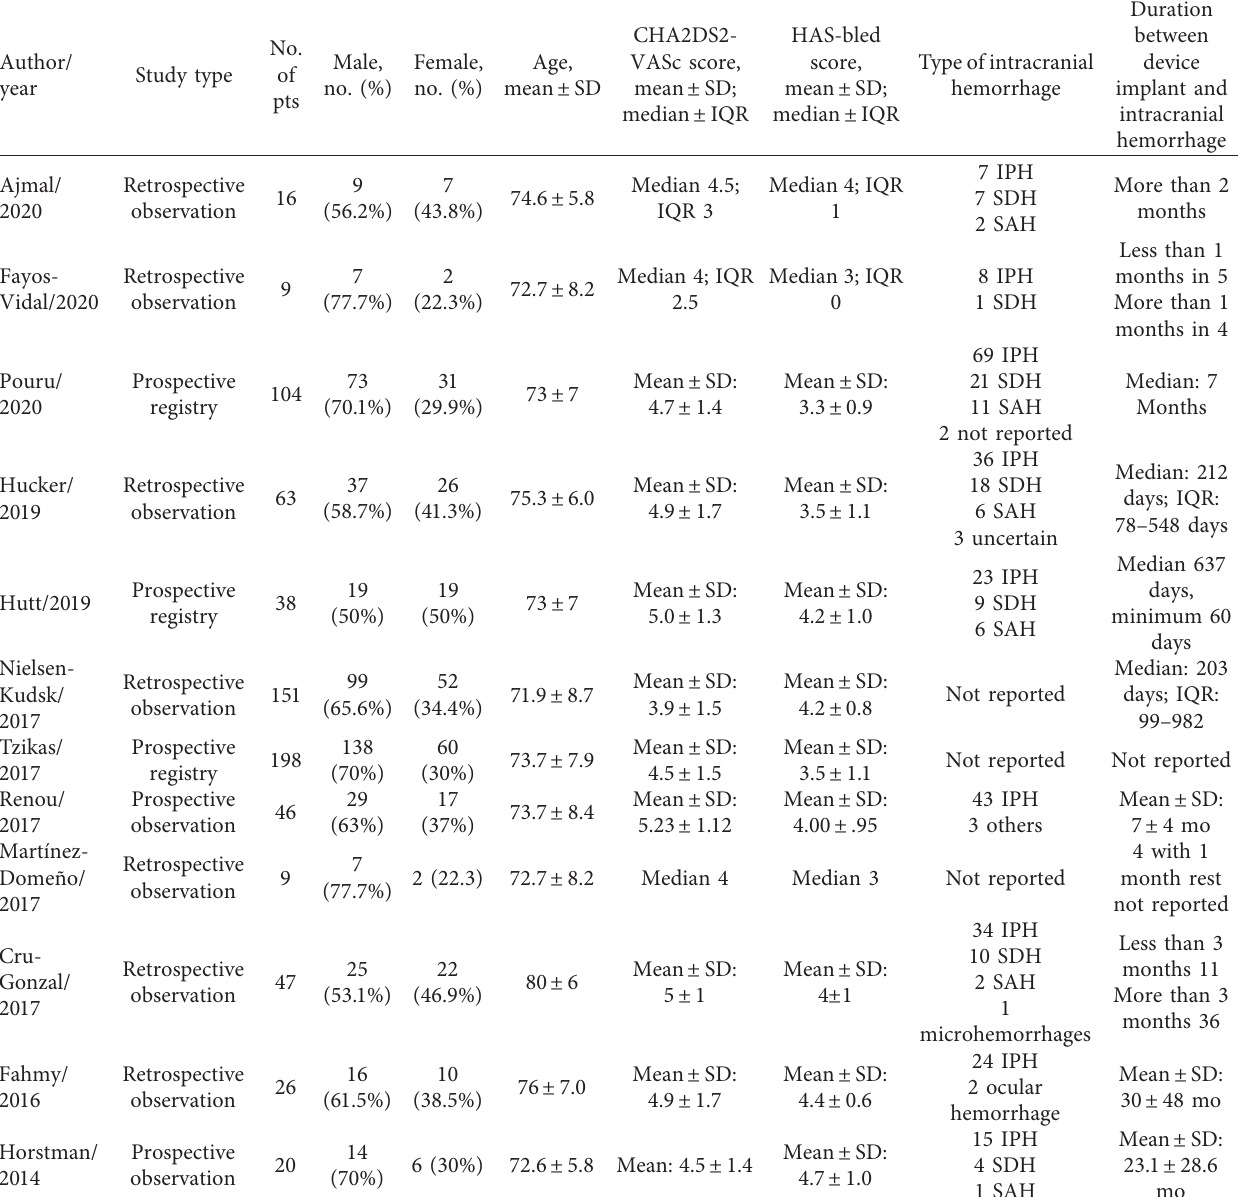
Table 1: Baseline characteristics of all